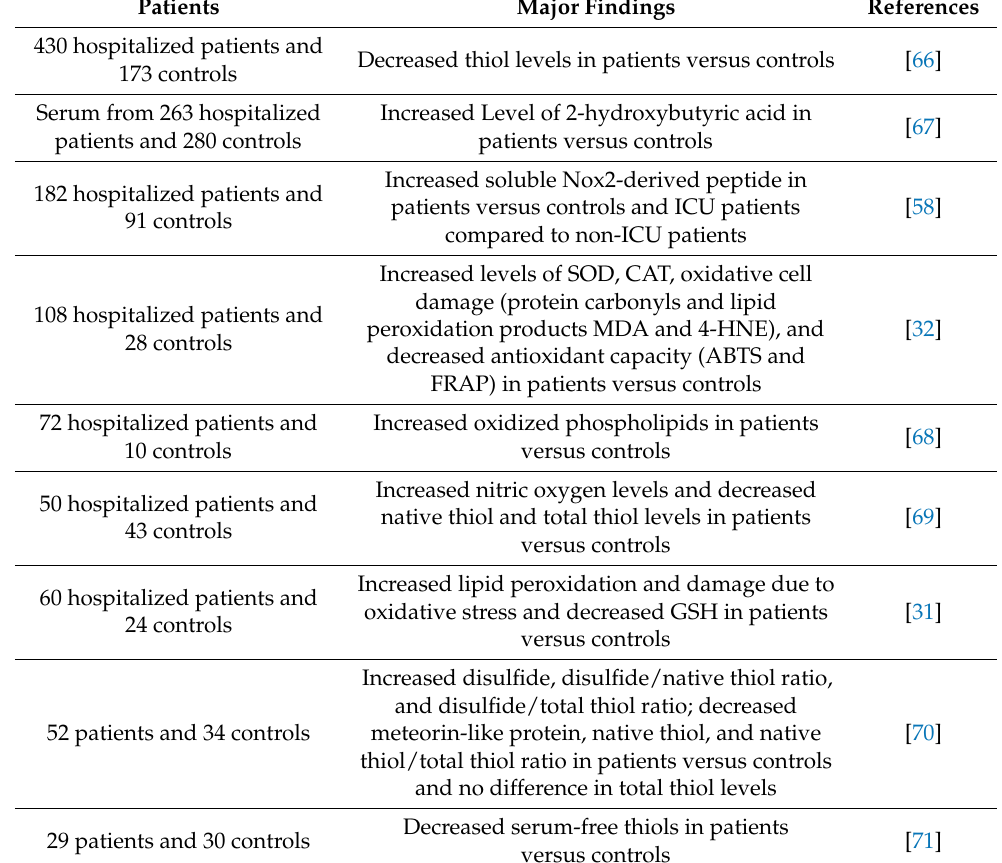
Table 1. Overview of COVID-19 case-control studies related to oxidative